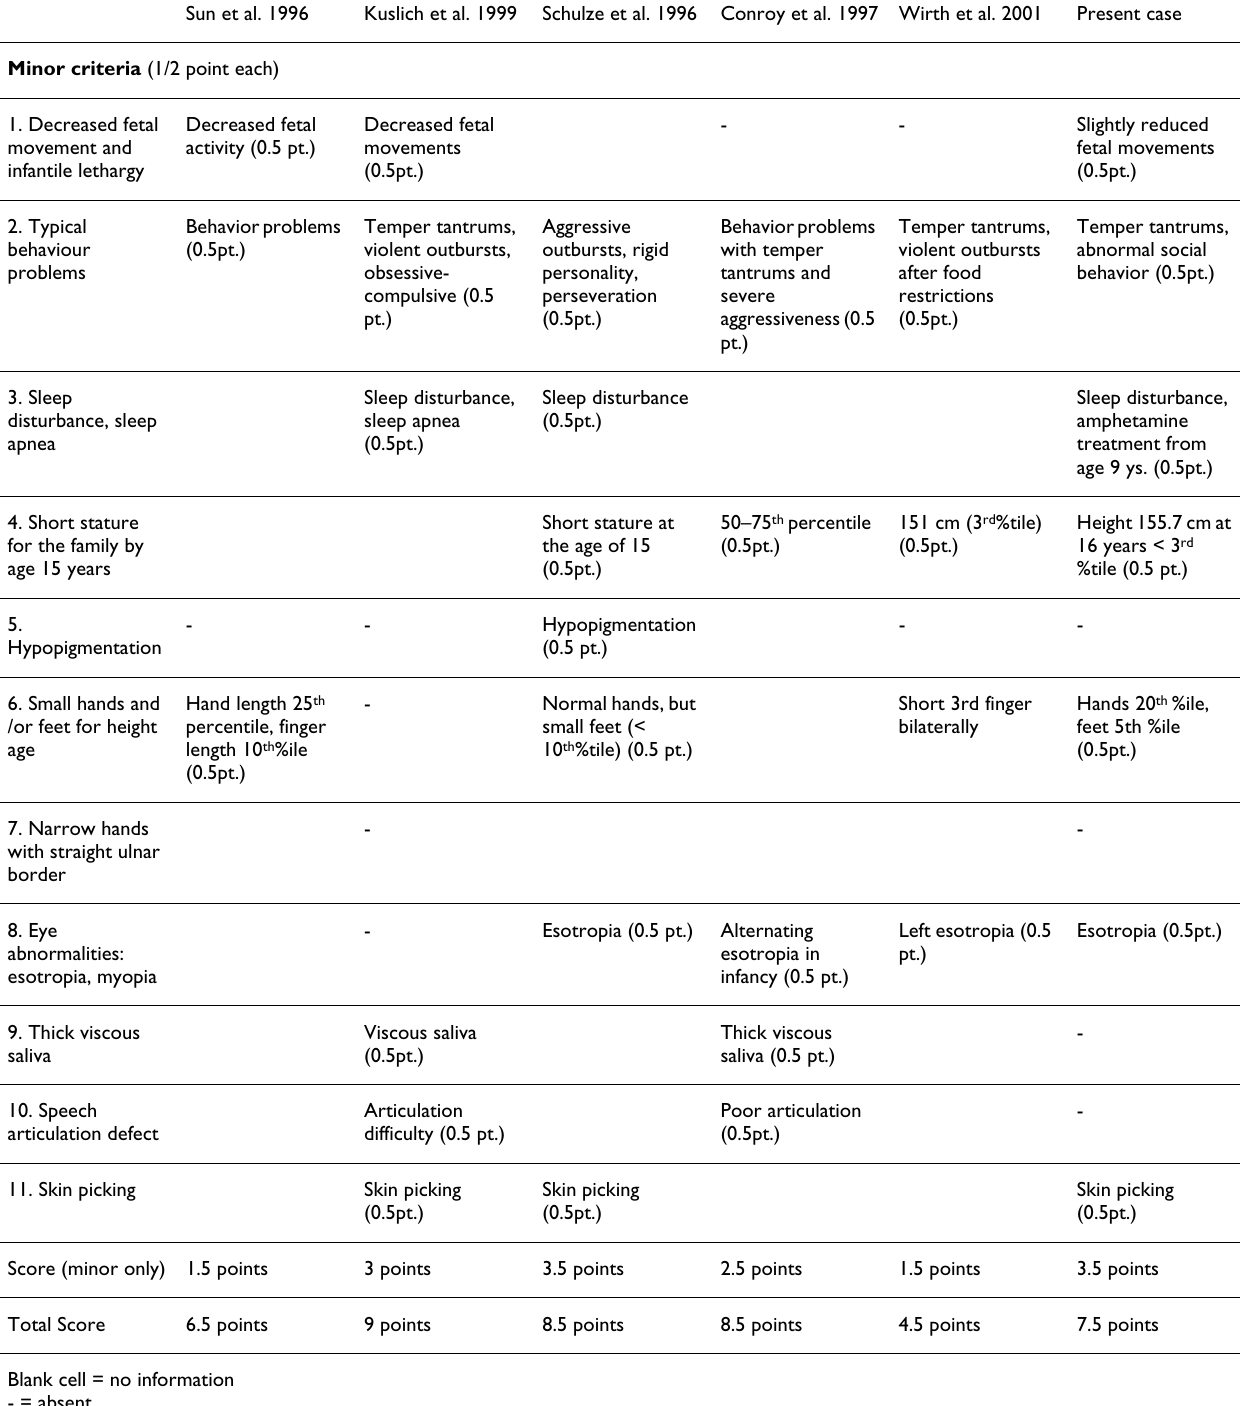
Table 4: Clinical findings associated with paternally-derived de novo reciprocal translocations involving SNRPN (continued) Sun et al.